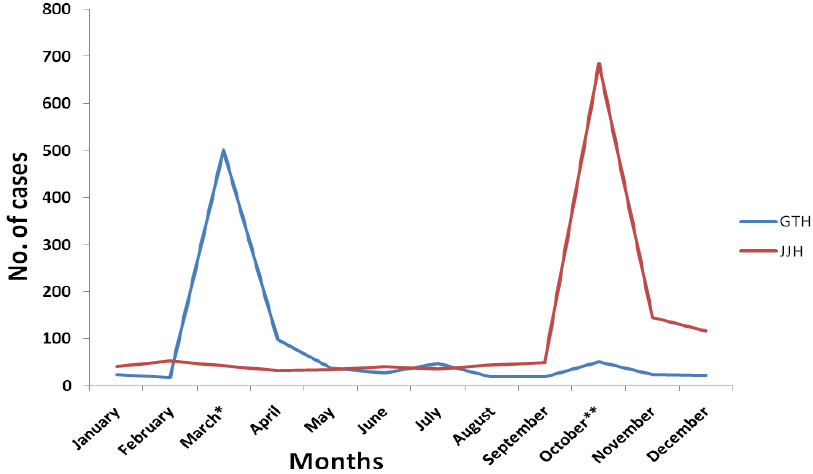
Figure 1. Frequencies of admission of patients with gastroenteritis referred to GTH